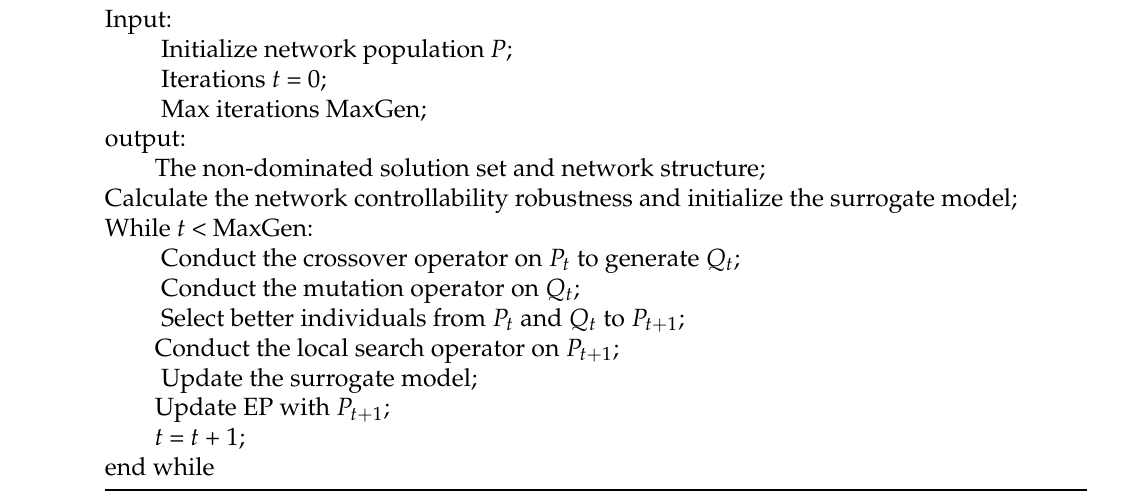
Algorithm 1: Multi-objective evolutionary algorithm